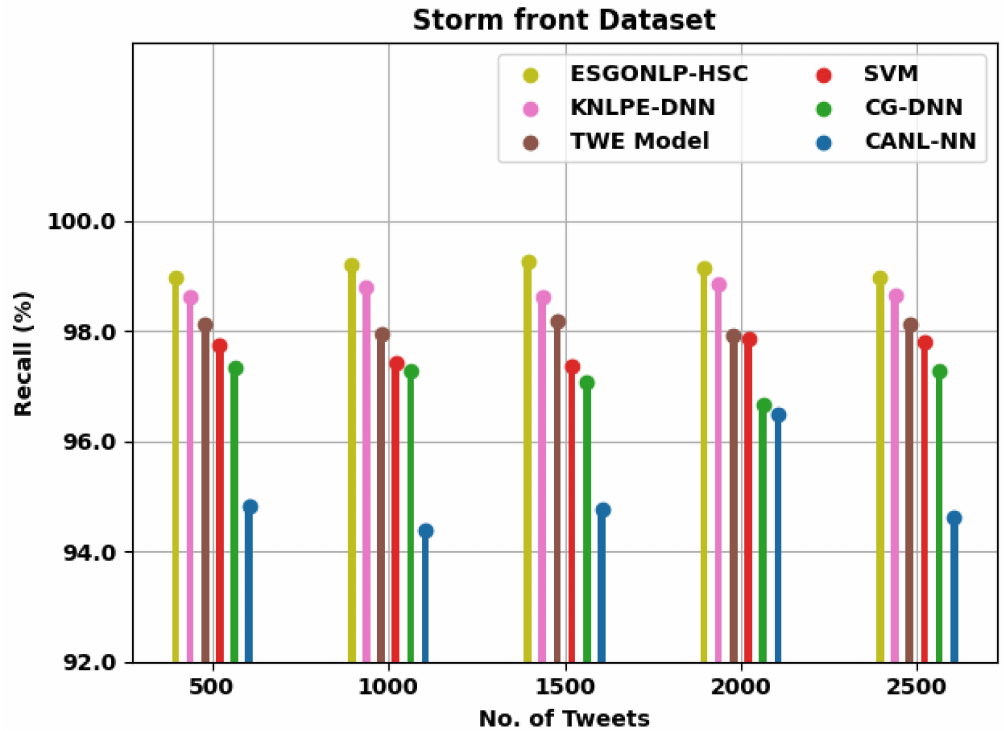
Figure 7. Reca l analysis of ESGONLP-HSC technique under Storm front